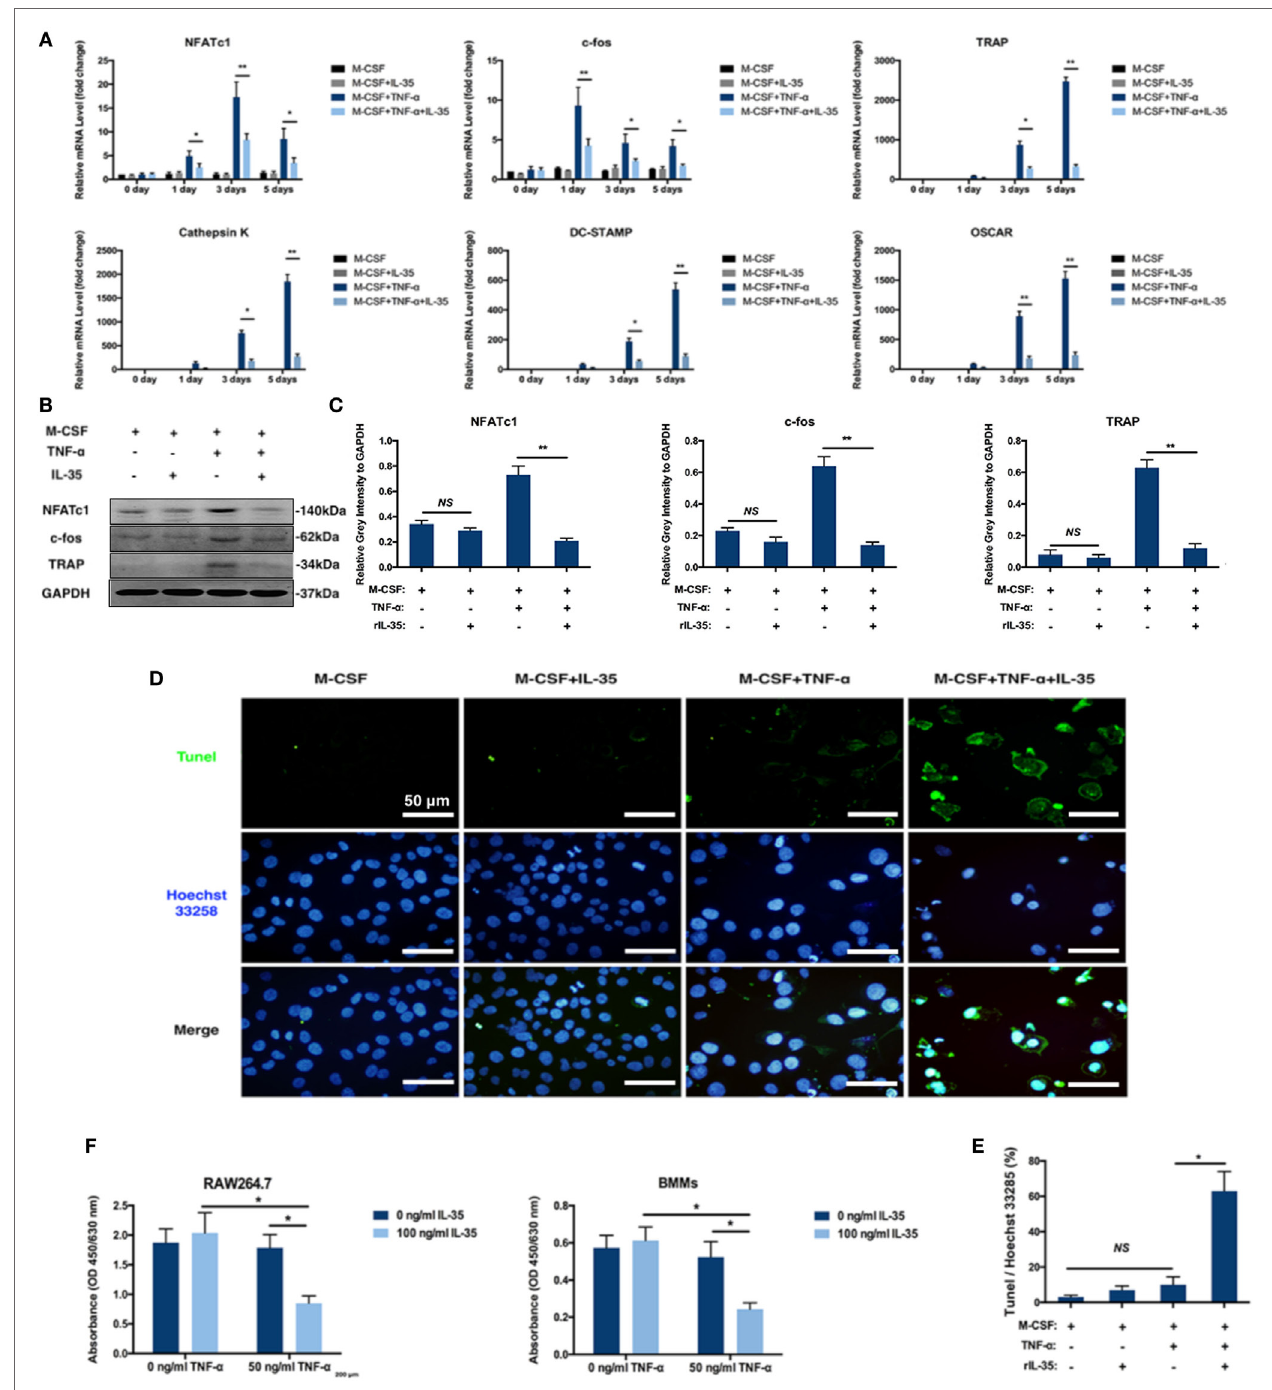
FigUre 2 | The effect of IL-35 on the expression of osteoclastogenesis associated genes and TNF- α -induced apoptosis. (a) RT-PCR analysis to detect the expression of osteoclastogenesis-related genes. (B) NFATc1, c-fos, and tartrate-resistant acid phosphatase (TRAP) were measured by western blot. (c) The relative gray intensity of NFATc1, c-fos, and TRAP to GAPDH. (D, e) Tunel stain of bone marrow monocytes treated with different agents. (F) Cell proliferation detected by Cell Count Kit-8 (CCK-8). * p < 0.05, ** p <